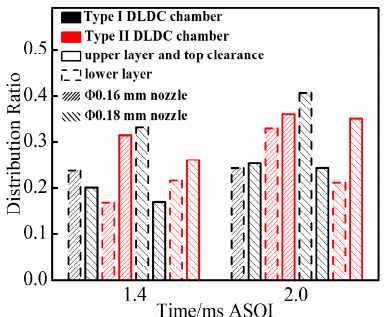
Figure 20. The layer fuel spray distribution ratio at different times with full load, different nozzles, 150 injection pressure and 15 °CA BTDC injection timing of Mode C.